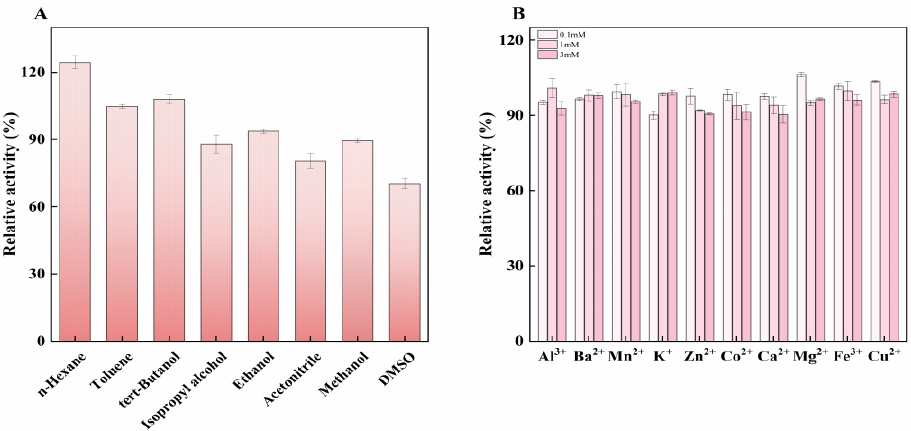
Figure 5. Effect of various organic solvents and metal ions on LUCA–DmpA. ( A ) LUCA–DmpA incubated with eight different organic solvents (50%, v / v ) for 30 min. ( B ) Effect of different metal ions of varying concentrations (0.1 mM, 1 mM and 3 mM) on the enzyme activity of LUCA−DmpA .